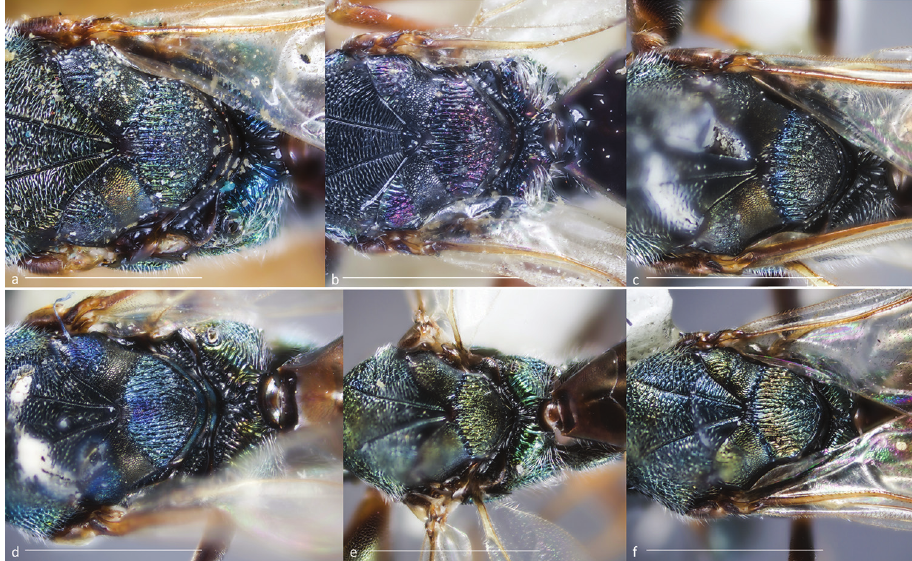
Figure 14. Mesoscutellum and propodeum (dorsal) I a O. ahoma (Mani & Kaul) (imaged specimen: OAh01, holotype) b O. circularicollis sp. n. (OCi01, holotype) c O. felix sp. n. (OFe01, holotype) d O. fi- delis sp. n. (OFi01, holotype) e O. florea sp. n. (OFl01, holotype), f O. formosa (Giraud) (OFo14). Scale bars: 1 mm.